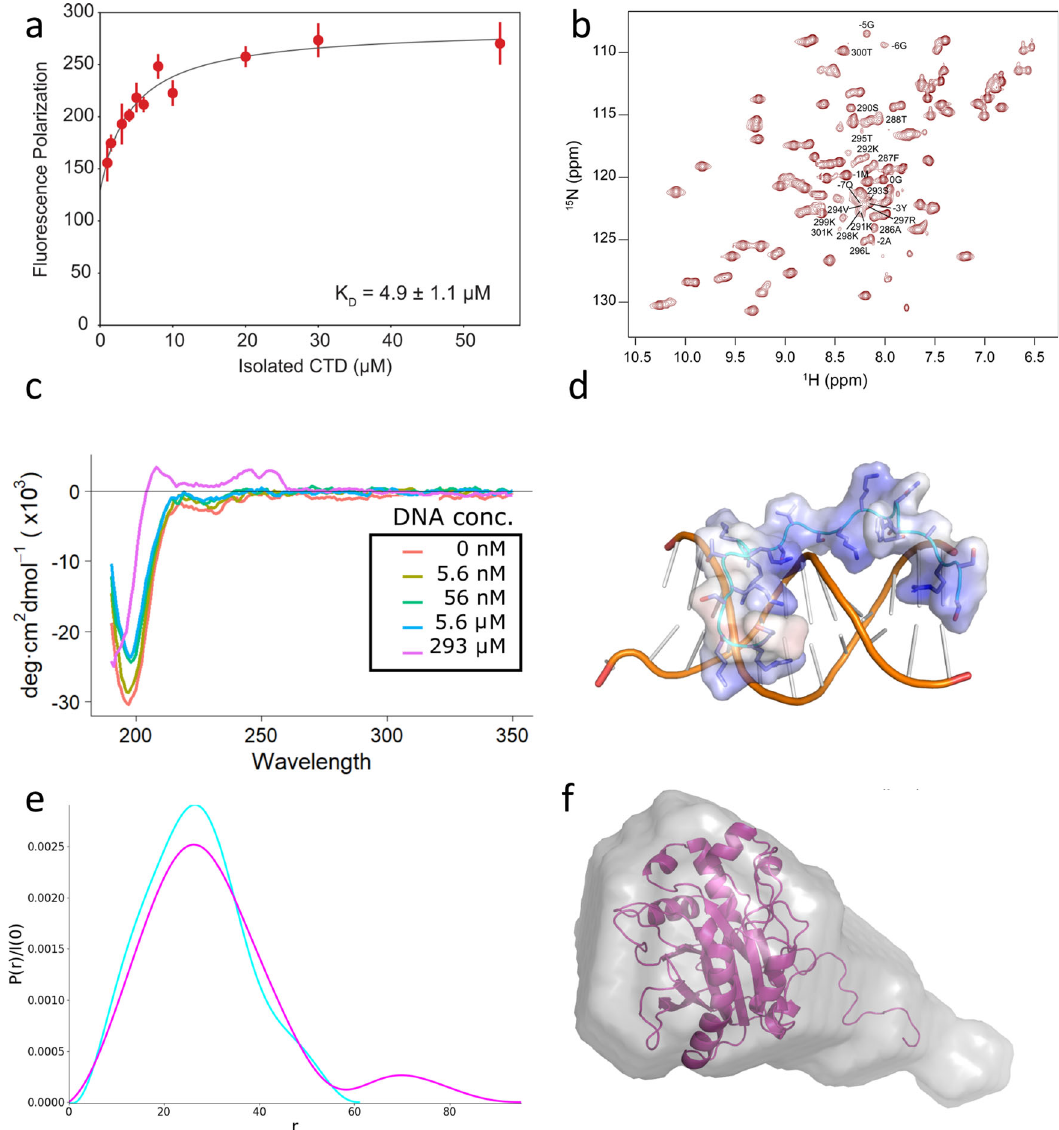
Fig. 6 The CTD interacts with DNA. a Fluorescence Polarization of the CTD peptide with a fl uorescently labeled 40-mer of dsDNA in 100 mM NaCl. Error bars represent SEM, n = 42 independent fl uorescence polarization measurements (3 replicates for each concentration). b NMR HSQC spectrum of SH3- CTD, which corresponds to the highly ordered and conserved SH3 domain and disordered CTD. The residues of the CTD domain (in Dnase1L3 numbering, missing the last 4 AA's peaks which are unidenti fi able) and the linker from the SH3 construct (numbered − 7 to 0) are labelled, the SH3 domain constitutes the remaining peaks. c Far-UV Circular Dichroism of the CTD peptide with increasing concentration of substrate dsDNA. d Snapshot of the CTD peptide interacting with DNA from MD simulation. e Pair distribution function created using GNOM as implemented in BioXTAS RAW. The SAXS data indicates a population of scattering atoms ~40 Å from the centroid of Dnase1L3 that was identi fi ed as the CTD. f SAXS bead model fi t, calculated using MultiFOXS, of the combined Dnase1L3 + CTD with a 16-mer of dsDNA and the NMR structure of the CTD equilibrated in an explicit solvent box. The MD simulations were run for a total of 1 μ S in NAMD using the CHARMM36m force fi eld. Our MD results corroborate the proposed DNA localizing role of the CTD with an immediate attraction towards the dsDNA (Fig. 6d) (Fig. S10a, b). The CTD was fl exible during DNA binding and stabilized to two distinct conformations between molecular dynamics simulations (Fig. S10c, d). However, between simulations the intrinsically disordered CTD remained disordered during its interaction with DNA (Fig. 6c). In summary our data shows that the intrinsically disordered C-terminal domain interacts with DNA to increase Dnase1L3 ’ s net af fi nity for its DNA substrate.